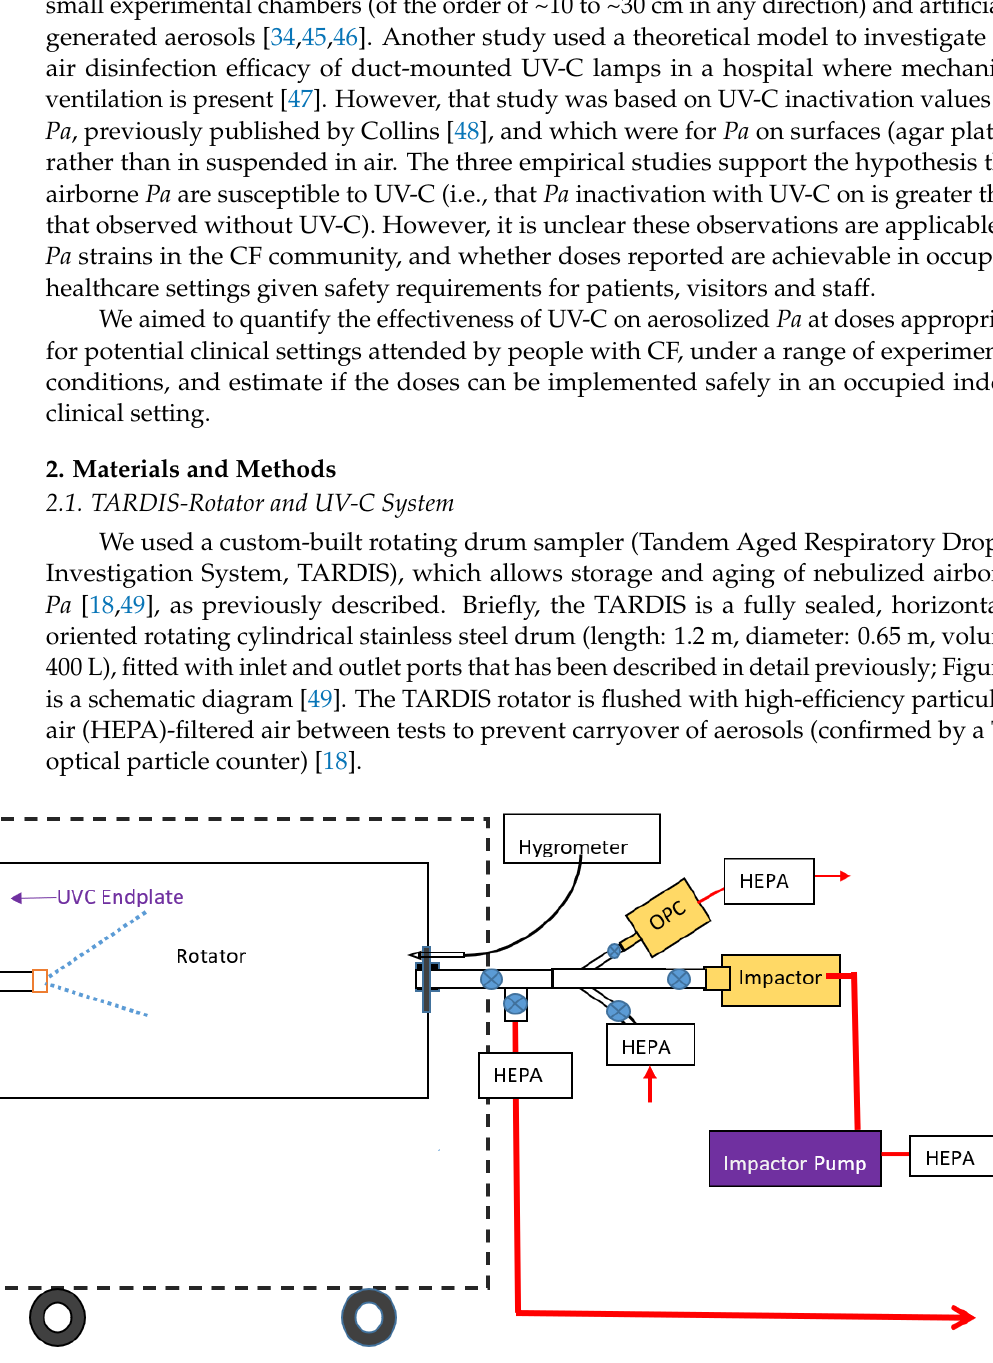
Figure 1. Schematic diagram of equipment and Pa nebulization and UV-C treatment. Note, the LEDs were mounted on the left end plate of the rotator. The rotator is 1.2 m long with diameter: 0.65 m (volume: 400 L).